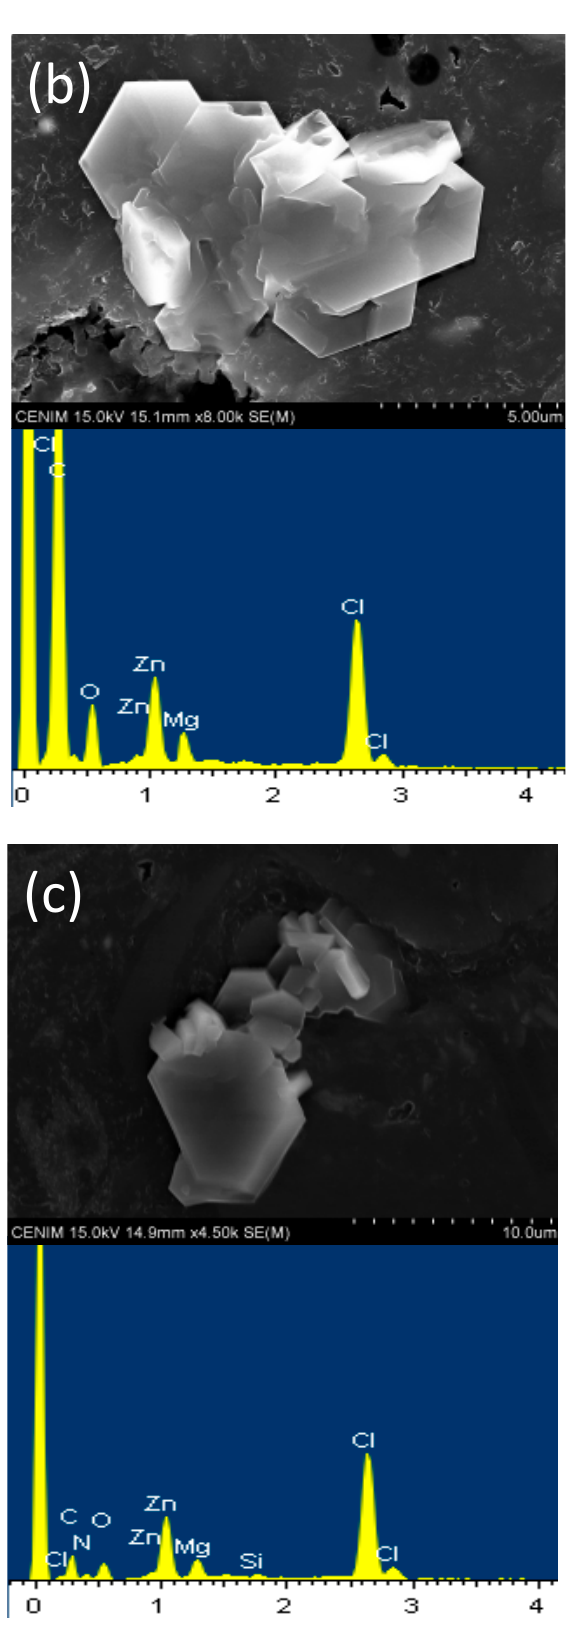
Figure 7. SEM micrographs and EDS spectra of the SP samples from the isothermal experiment at 700 °C for the BM/CaCl 2 /CB system: ( a ) VBM-1, ( b ) VBM-2, and ( c ) SBM.